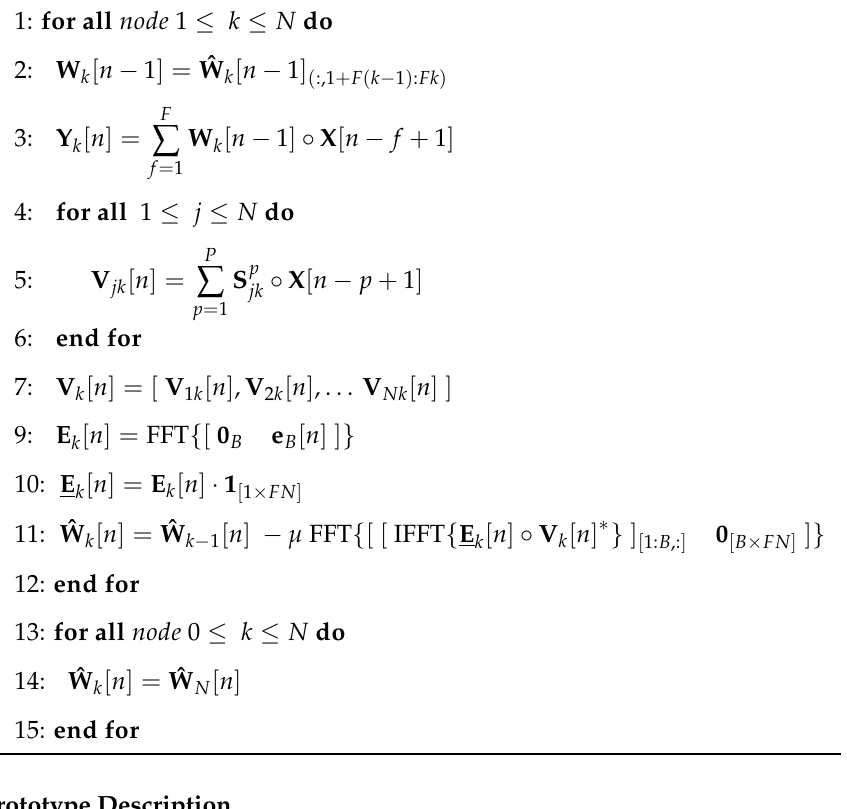
Algorithm 1 Distributed FPBP x LMS Algorithm for N -nodes